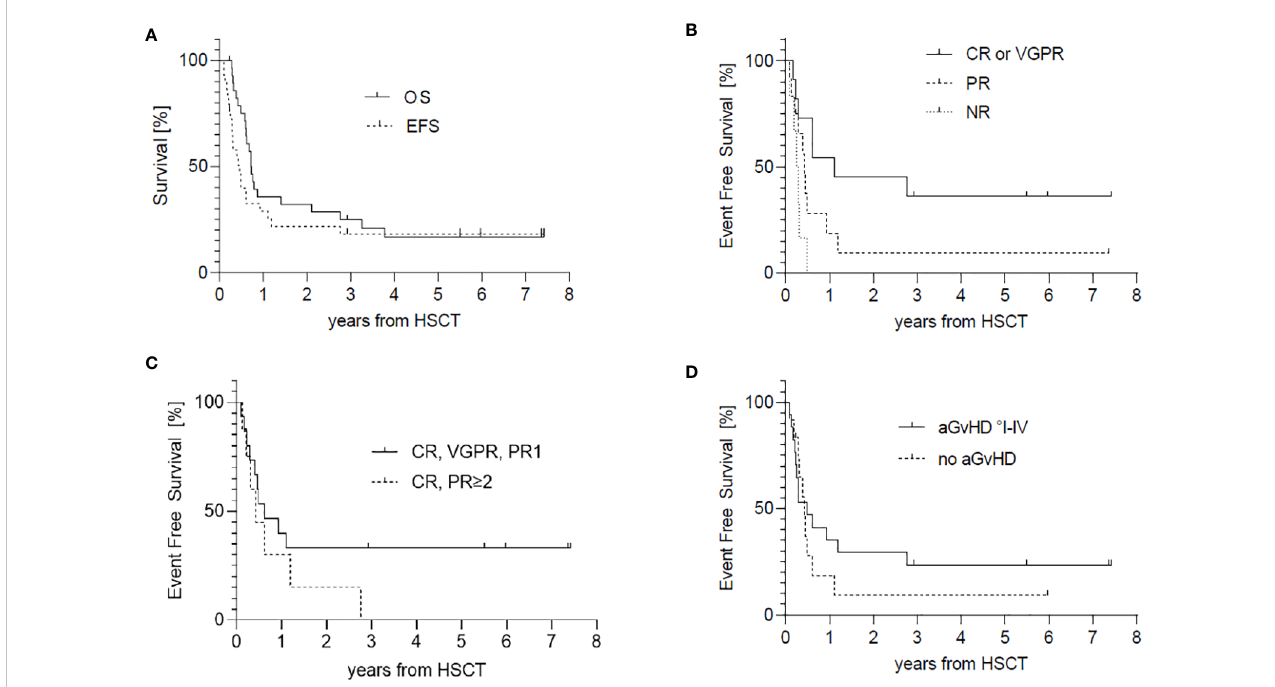
FIGURE 3 Survival, counted from haploidentical HSCT. (A) Probability of Overall Survival (OS) and Event Free Survival of the entire cohort. (B) EFS according to pre- transplant remission status CR/VGPR vs. PR or NR. (C) EFS of patients achieving fi rst PR or better compared to patients in CR/PR, who were transplanted after relapse. (D) EFS in accordance with the occurrence of aGvHD.